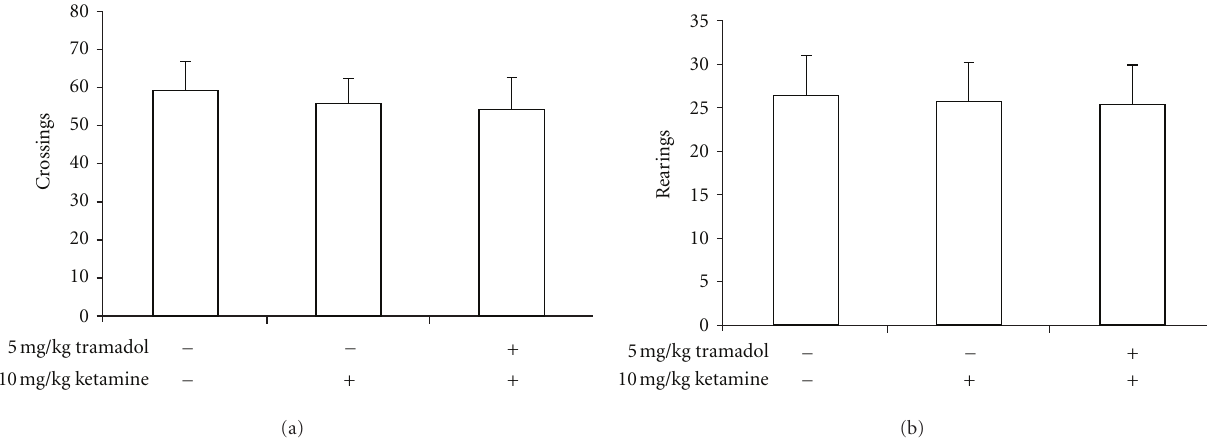
Figure 2: (a) The scores of crossings of rats ( n = 10) during open-field tests. Ketamine administered at the dose of 10 mg/kg did not a ff ect the scores of crossings, and pretreatment with 5mg/kg tramadol did not a ff ect any changes of scores of crossings ( P > 0 . 05). (b) The scores of rearings of rats ( n = 10) during open-field tests. Ketamine administered at the dose of 10mg/kg did not a ff ect the scores of rearings, and pretreatment with 5mg/kg tramadol did not a ff ect any changes of scores of rearings ( P > 0 . 05).